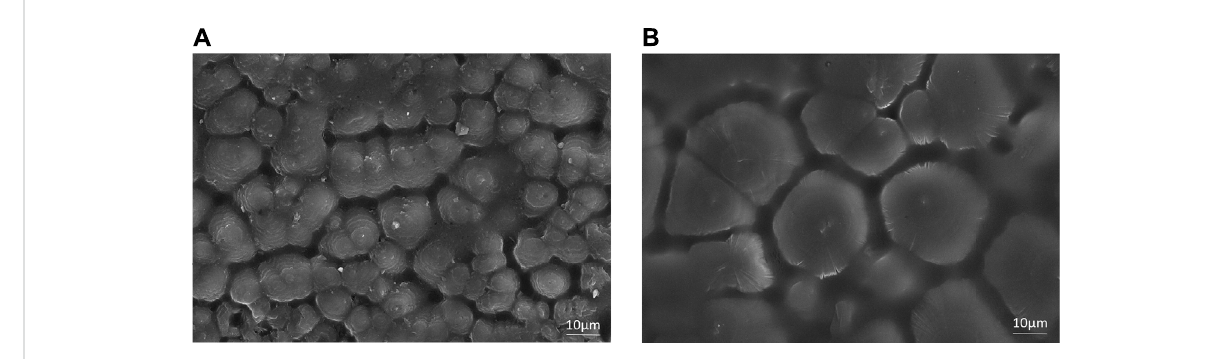
FIGURE 2 SEM images showing the spherulite form of (A) 70L – 30H blends and (B) XLPE.